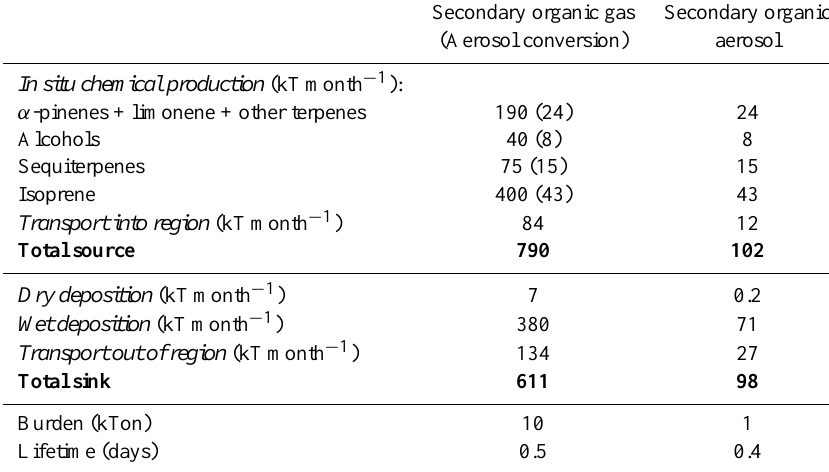
Table 4. GEOS-Chem model budget of secondary organic gas and secondary organic aerosol over Borneo, 25 June–25 July 2008. Secondary organic gas Secondary organic (Aerosol conversion) aerosol In situ chemical production (kTmonth − 1 ): α -pinenes + limonene + other terpenes 190 (24) Alcohols 40 (8) Sequiterpenes Isoprene 400